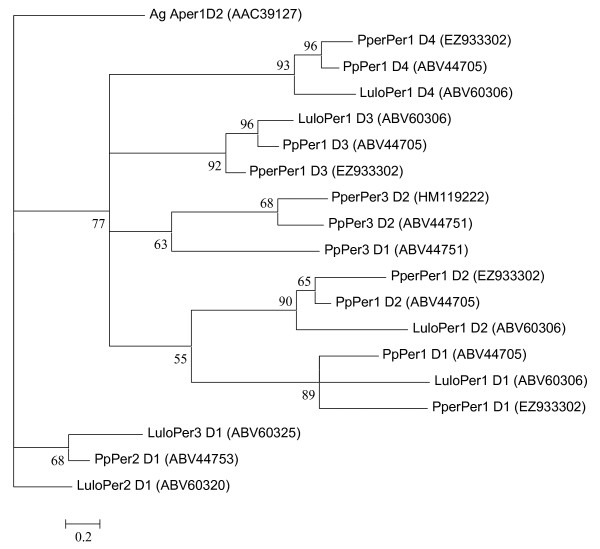
Phylogenetic analysis of predicted chitin-binding domains of putative peritrophins from Anopheles gambiae (Ag), Phlebotomus perniciosus (Pper), Lutzomyia longipalpis (Lulo) and Phlebotomus papatasi (Pp). GenBank accession numbers are given in parentheses and bootstrap values indicate node support.